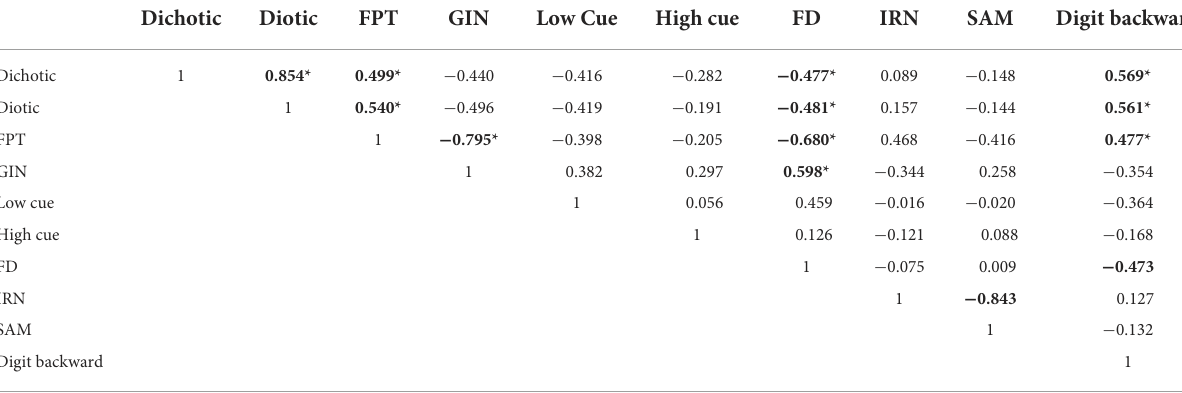
TABLE 6 Pearson’s correlation between auditory processing measures and the digit backward task. Dichotic Diotic FPT GIN Low Cue High cue FD IRN SAM Digit backward Dichotic